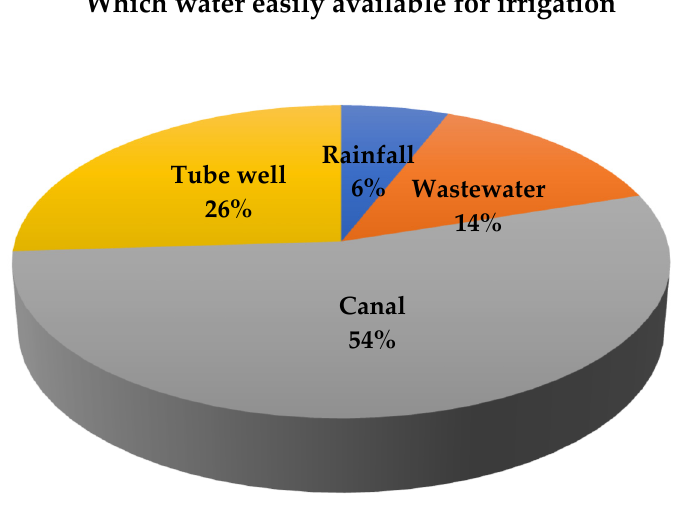
Figure 4. Availability of water for irrigation.